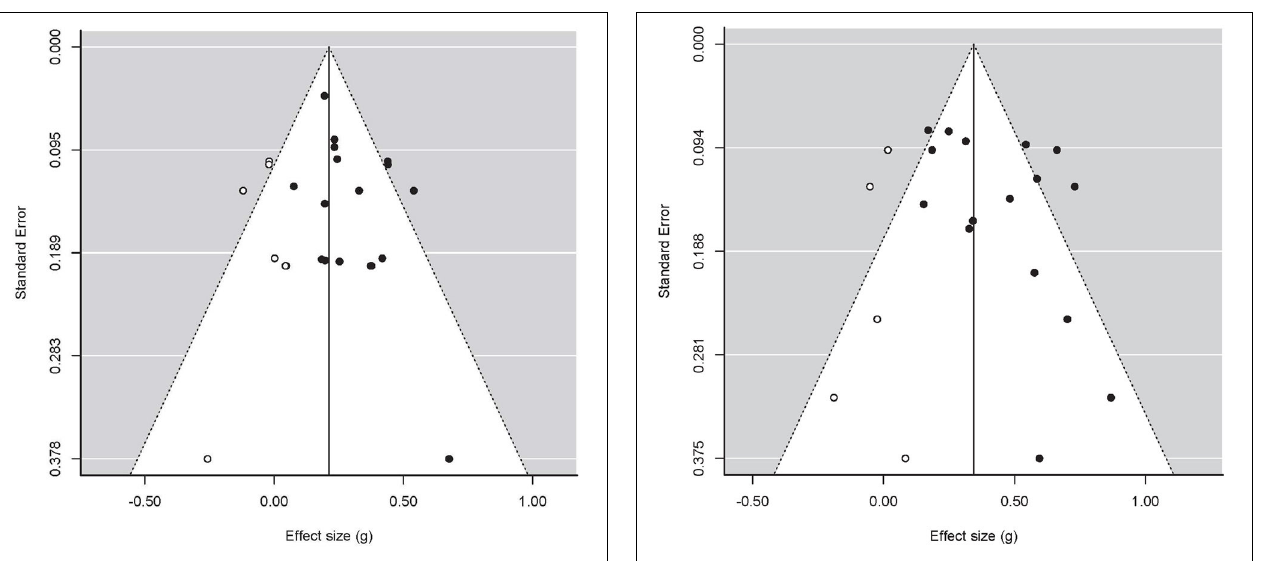
FIGURE 1 | Funnel plot for studies concerning Positive Affect, with treatment effects on the x-axis and the standard error on the y-axis. Closed circles are original data, open circles represent filled-in data based on the trim-and-fill method. Dotted lines represent 95% confidence interval around the mean.